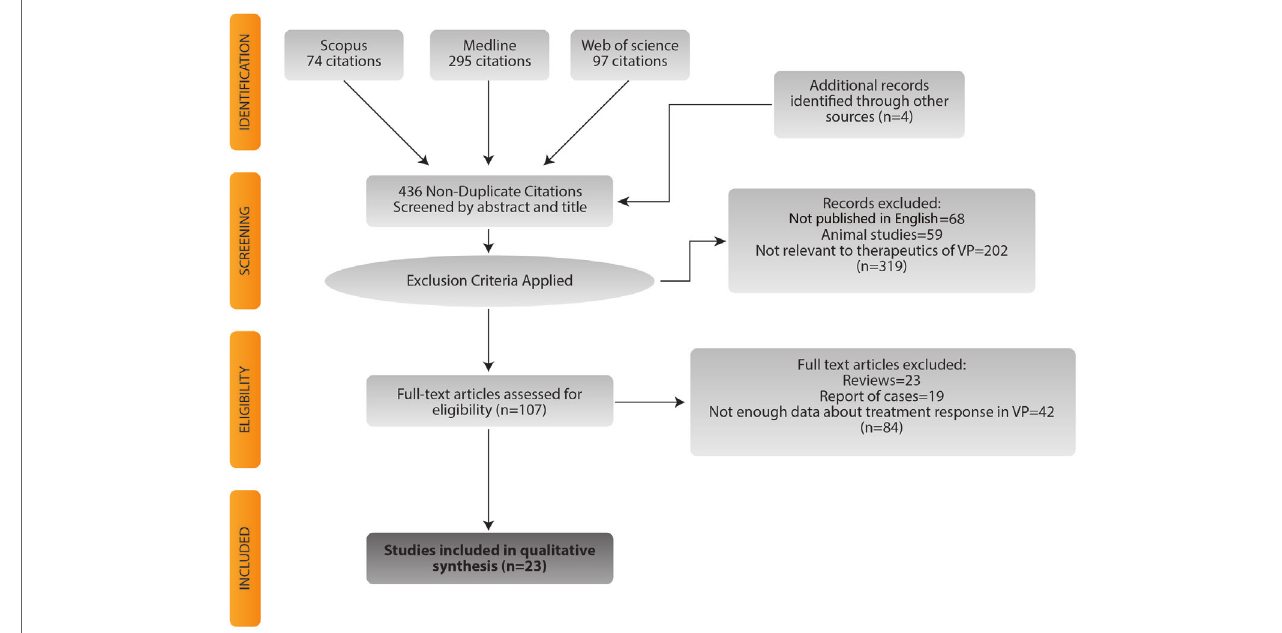
FigURe 1 | Flowchart for study